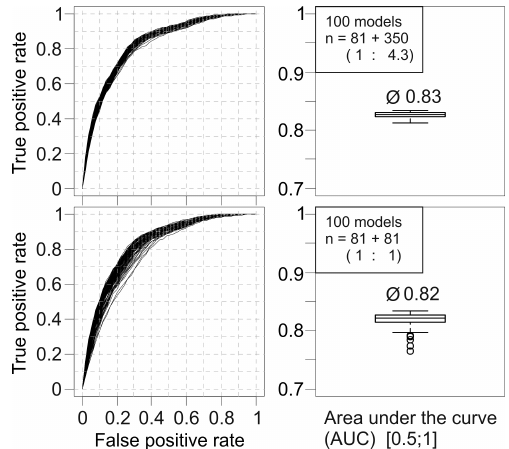
Fig. 8. Evaluation of the predictive ability of 100 models (top panels: n =350 non-event cells, bottom panels: n =81 non-event cells) by means of the area under the curve. As the model training (ZBT) and validation area (LT) are independent, the diagrams on the left represent prediction curves (Chung and Fabbri, 2003).